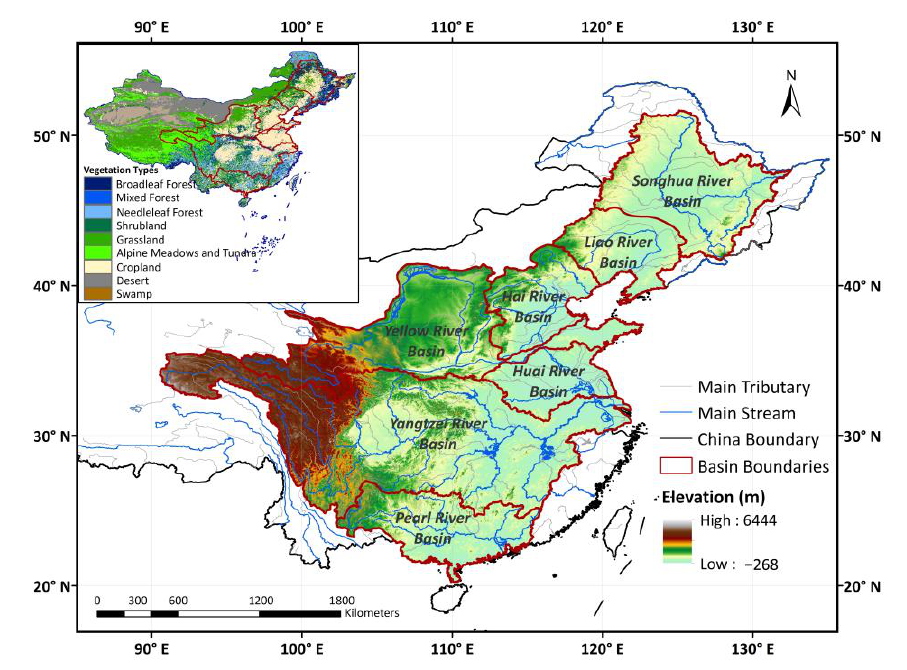
Figure 1. Spatial distribution of vegetation types and locations of seven major watersheds in China.